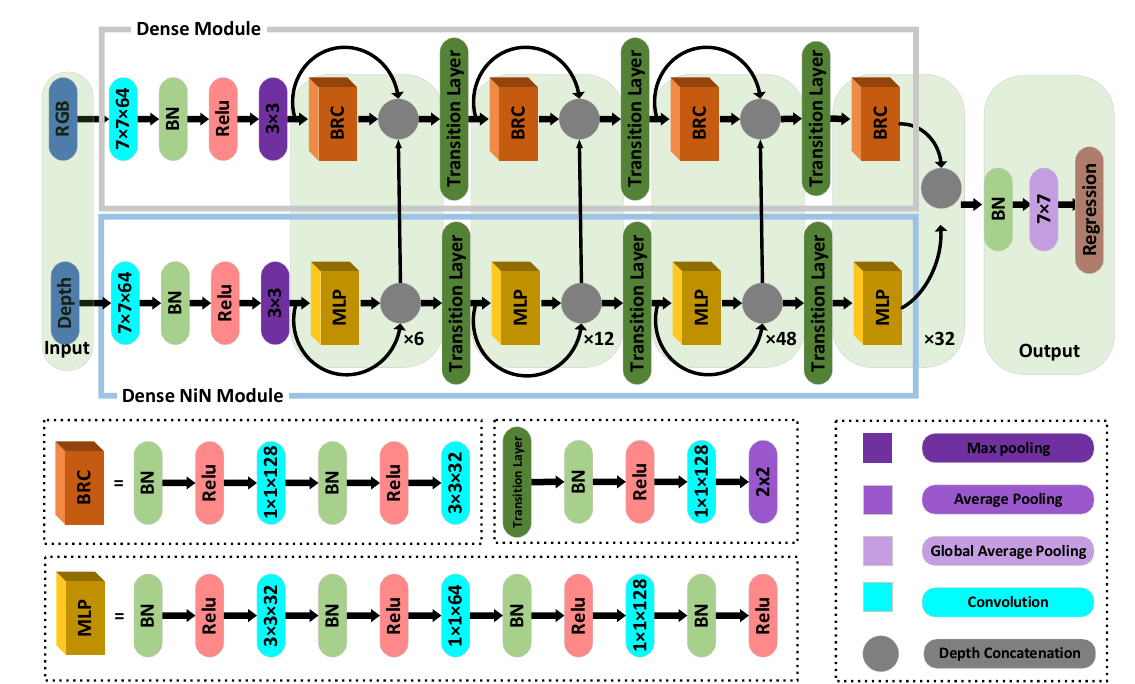
Figure 5. Two-stream dense feature fusion network (DenseNet201). The module color in the figure corresponds to the color comment block in the lower right corner. Batch Normalization is abbreviated as BN, and Rectified Linear Unit is abbreviated as